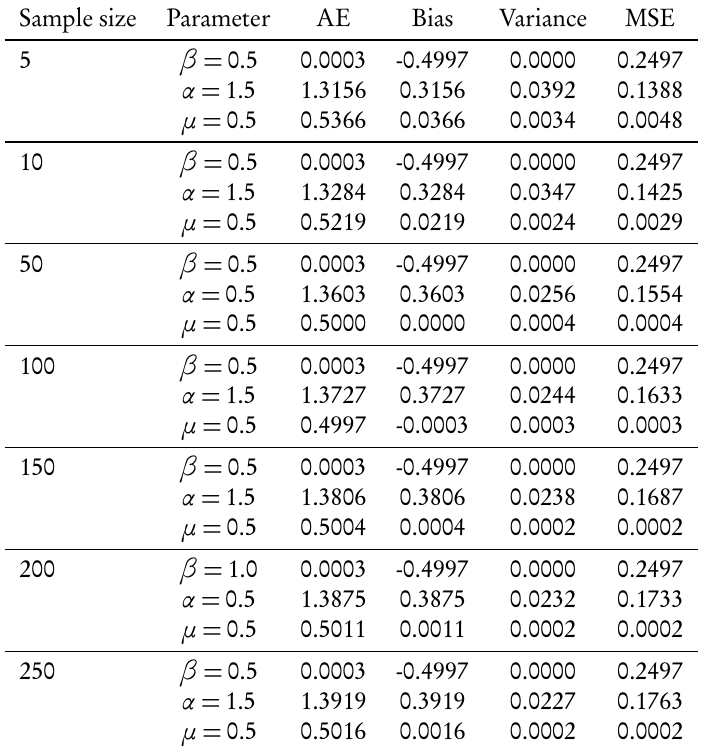
Monte Carlos simulation study for the MO-G